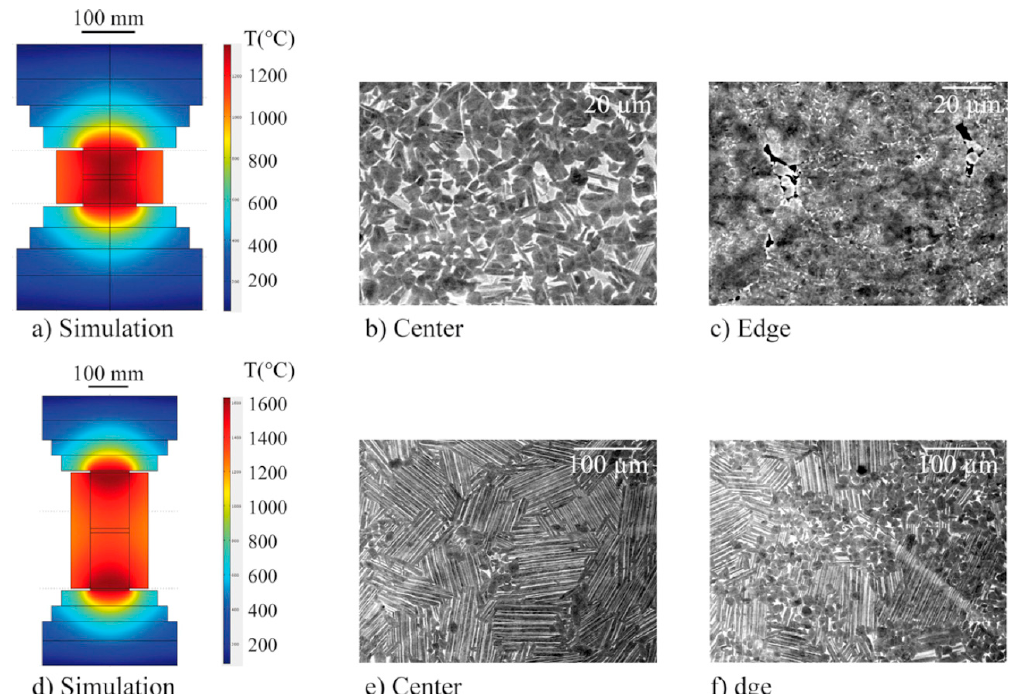
Figure 12. Temperature distribution in insulating ZrO 2 ( a ) and conducting TiN ( b ) samples during holding at 1500 °C [67]. Reproduced with permission from Acta Materialia, published by Elsevier, 2005.